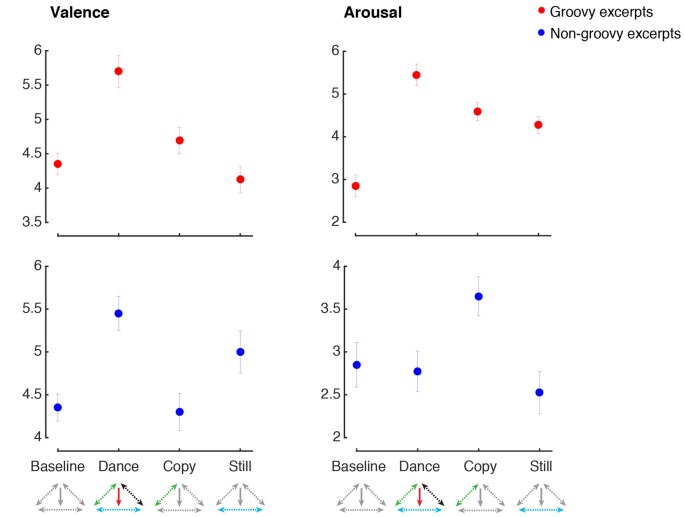
Emotion ratings. The figure shows the emotion ratings for the two emotional dimensions examined, across the four experimental conditions (Baseline, Dance, Copy, Still). Ratings for the groovy excerpts are shown with red markers, and ratings for the non-groovy excerpts are shown with blue markers. Error bars represent means ± standard error. Along the horizontal axis, below the name of the experimental conditions, the model presented in Figure 1 is shown, with colored arrows indicating the component of the model presumably activated in each condition.